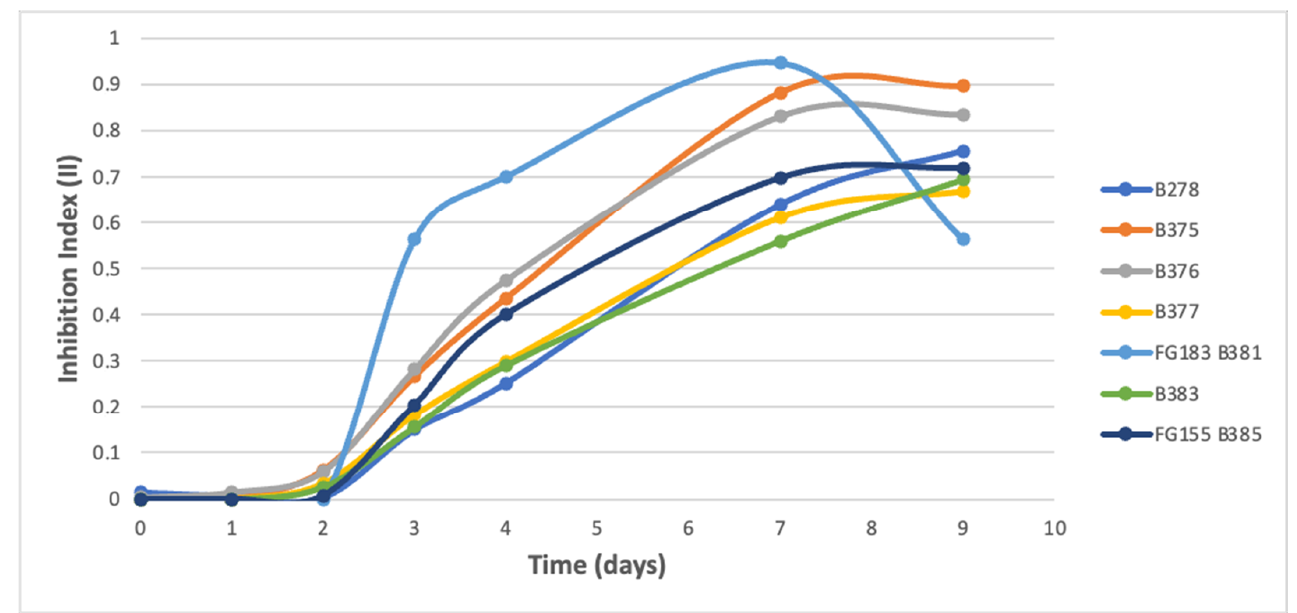
Figure 3. Kinetic curves of global inhibition indexes from the challenge co-cultures of Bacillus velezensis B25 against pathogenic fungi Gaeumannomyces graminis B278; Fusarium graminearum B375; Fusarium culmorum B376; Fusarium graminearum B377; Fusarium graminearum FG183 B381; Fusarium graminearum B383 and Fusarium graminearum FG 155 B385.